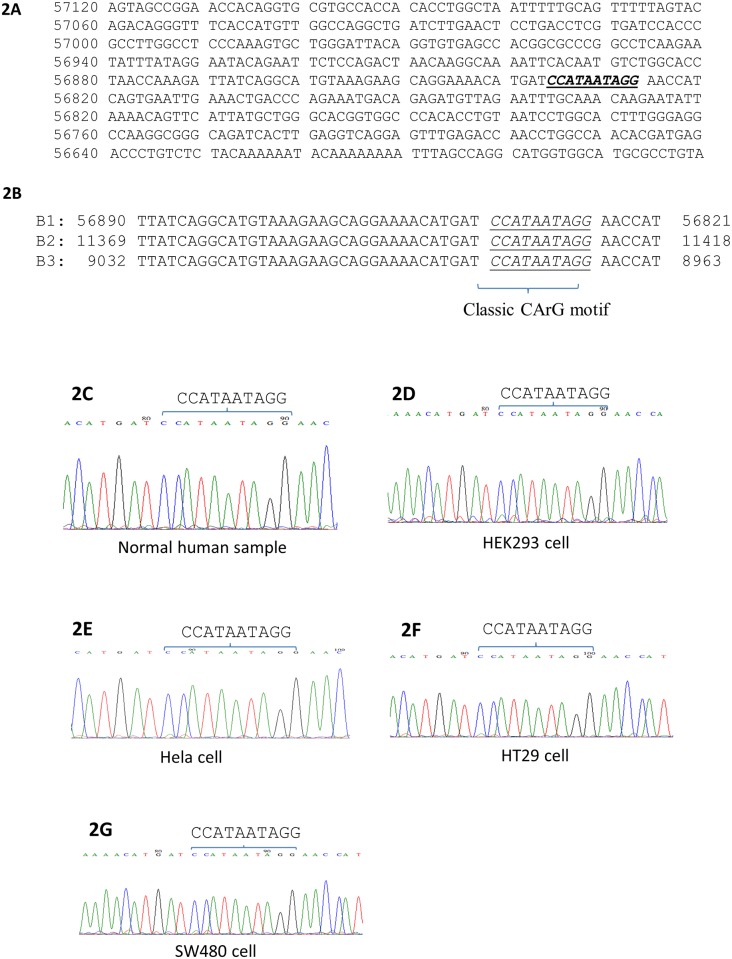
The classic SRE/CArG sequence in human SIRT2 gene promoter region.2A. Part of the DNA sequence from chromosome 19 clone CTC-360G5 (accession no. AC011455), showing a classic SRE sequence CCATAATAGG. 2B. Alignment of three DNA sequences that have been deposited in the GenBank database. B1: Homo sapiens chromosome 19 clone CTC-360G5, complete sequence (AC011455). B2: Homo sapiens BAC clone CH17-66M11 from chromosome 19 (AC256309). B3: Homo sapiens RefSeqGene on chromosome 19 (NG_029624). 2C-2G. Sequencing chromatograms of five DNA samples confirm the existence of a classic CArG motif “CCATAATAGG” sequence in the human SIRT2 gene promoter region. These DNA samples are from normal human donor (2C), HEK293 cells (2D), Hela cells (2E), HT29 cells (2F) and SW480 cells (2G).